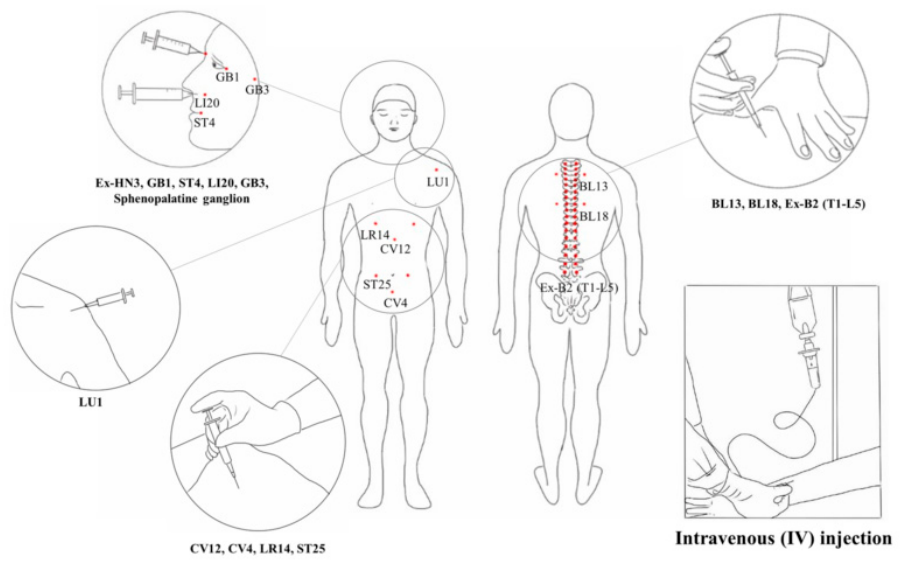
Figure 3. Intravenous and acupoint injections of pharmacopuncture. The area inside the circle means the acupoint injection site or each acupuncture point. the acupoint injection site or each acupuncture